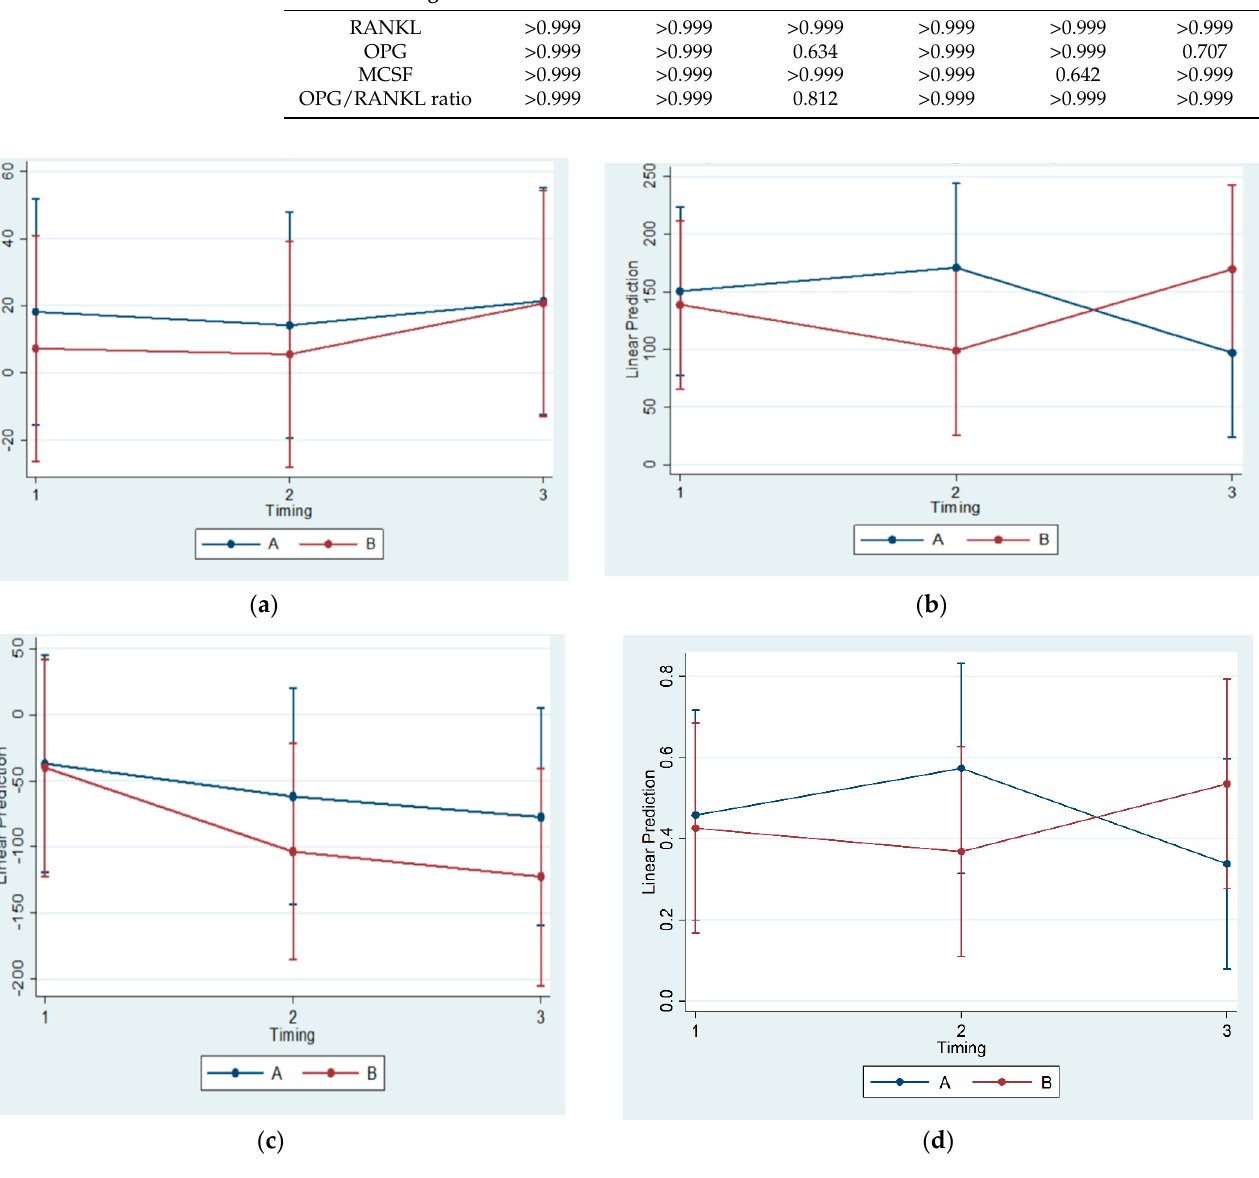
Figure 5. Estimated mean change (final–initial) and 95% confidence interval per group and timing in RANKL ( a ), OPG ( b ), MCSF ( c ), and OPG–RANKL ratio ( d ).